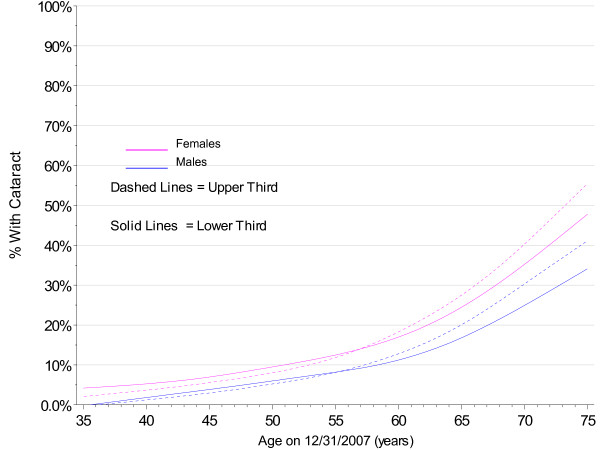
Smoothed 2007 Prevalence of Cataract by Gender and Antioxidants (lower vs. upper third) Cohort with No Diabetes.